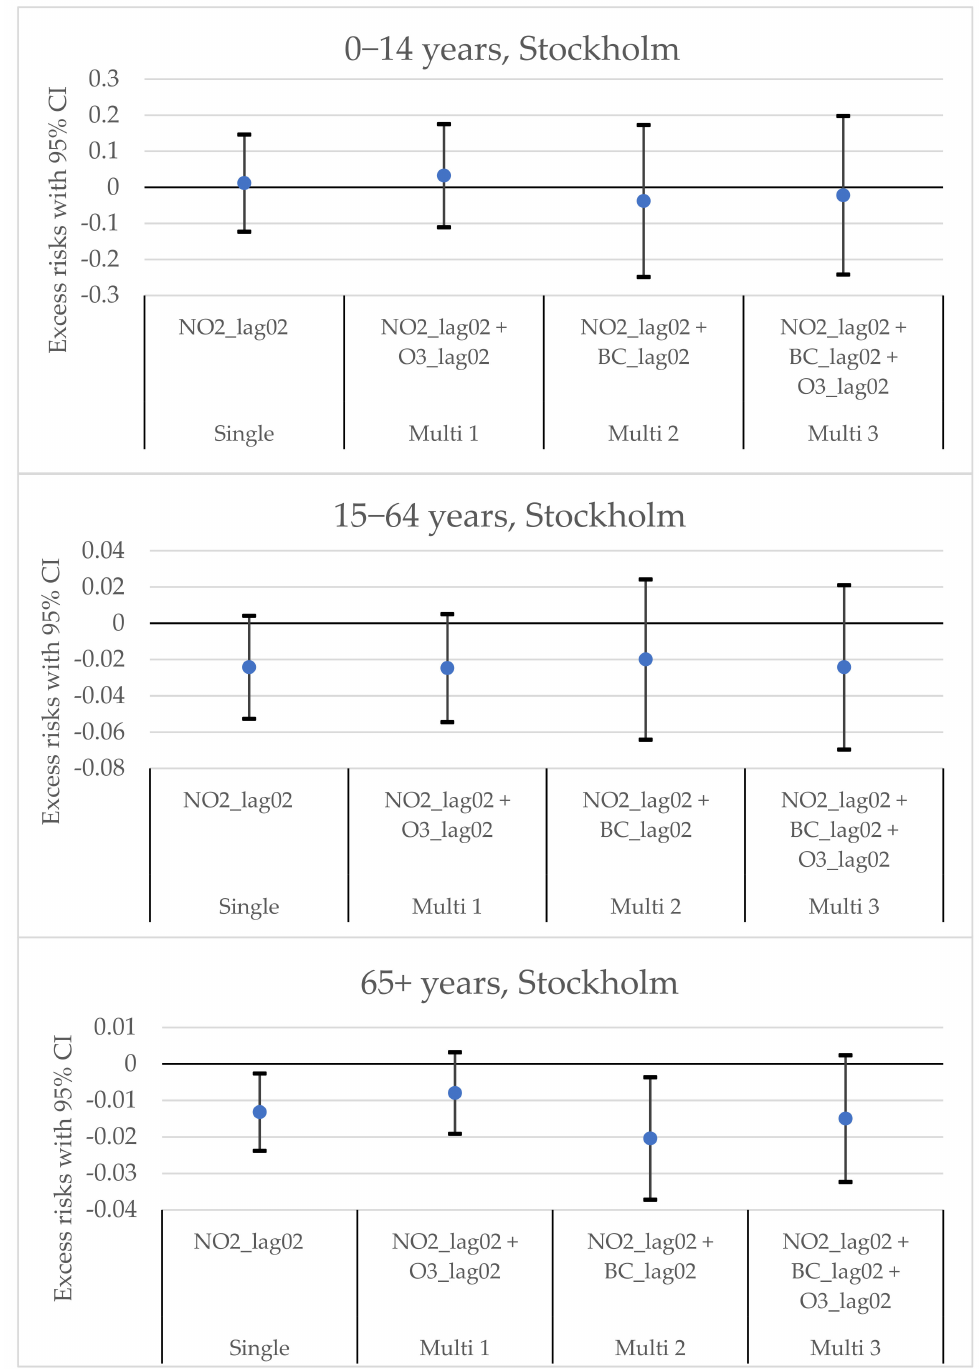
Figure 7. Multi-pollutant models of the estimated change in daily mortality in different age groups (with 95% CI) for an IQR increase in the concentration of NO 2 (lag02) in Stockholm. From left to right: a single-pollutant estimate of NO 2 (Single), NO 2 adjusted for O 3 (Multi 1), NO 2 adjusted for BC (Multi 2), and NO 2 adjusted for both BC and O 3 (Multi